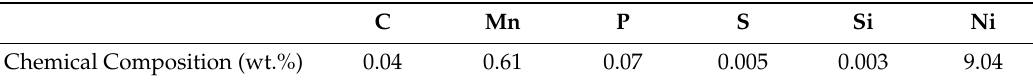
Table 1. Chemical composition of 9% Ni steel in wt. % with Fe to balance.